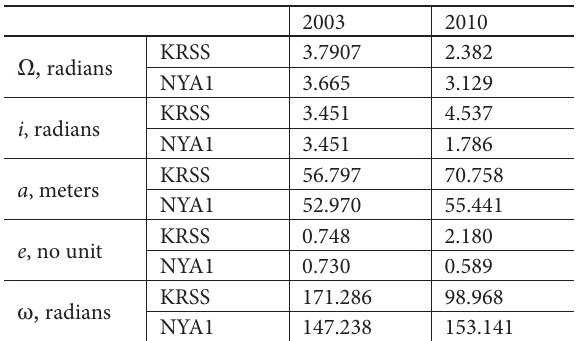
Table 2. The summary of results showing the range of differenc- es (The range in this context is defined as the difference between the highest and lowest